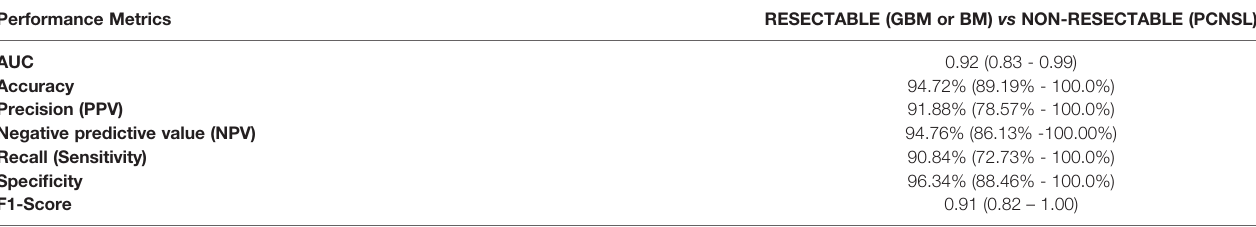
TABLE 2 | Convolutional neural networks model ’ s performance metrics in suggesting lesion resectability. Performance Metrics